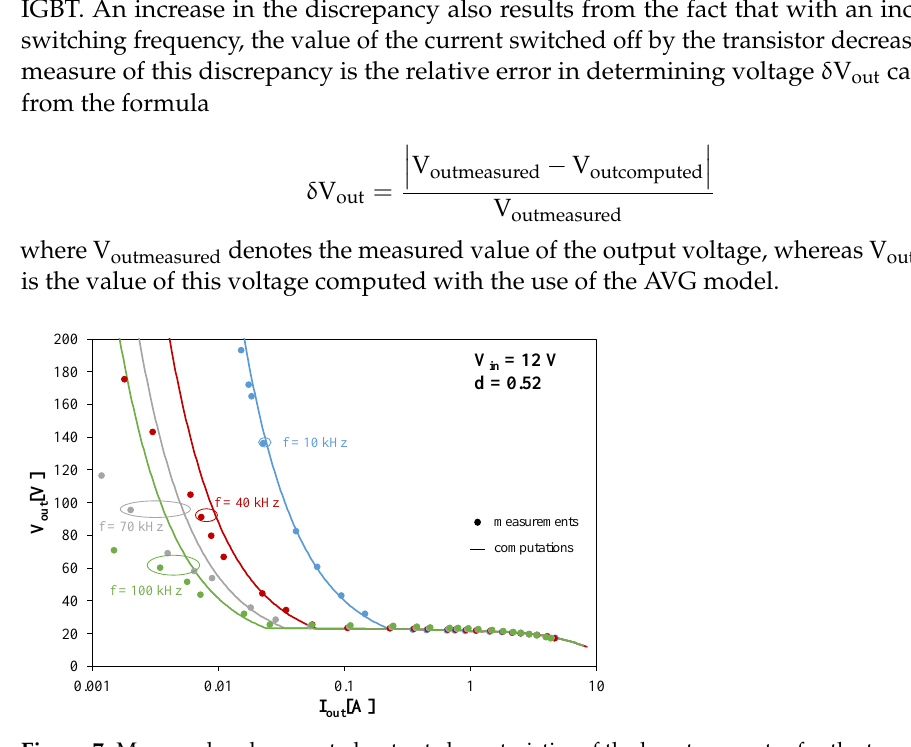
shown in Figure 8.